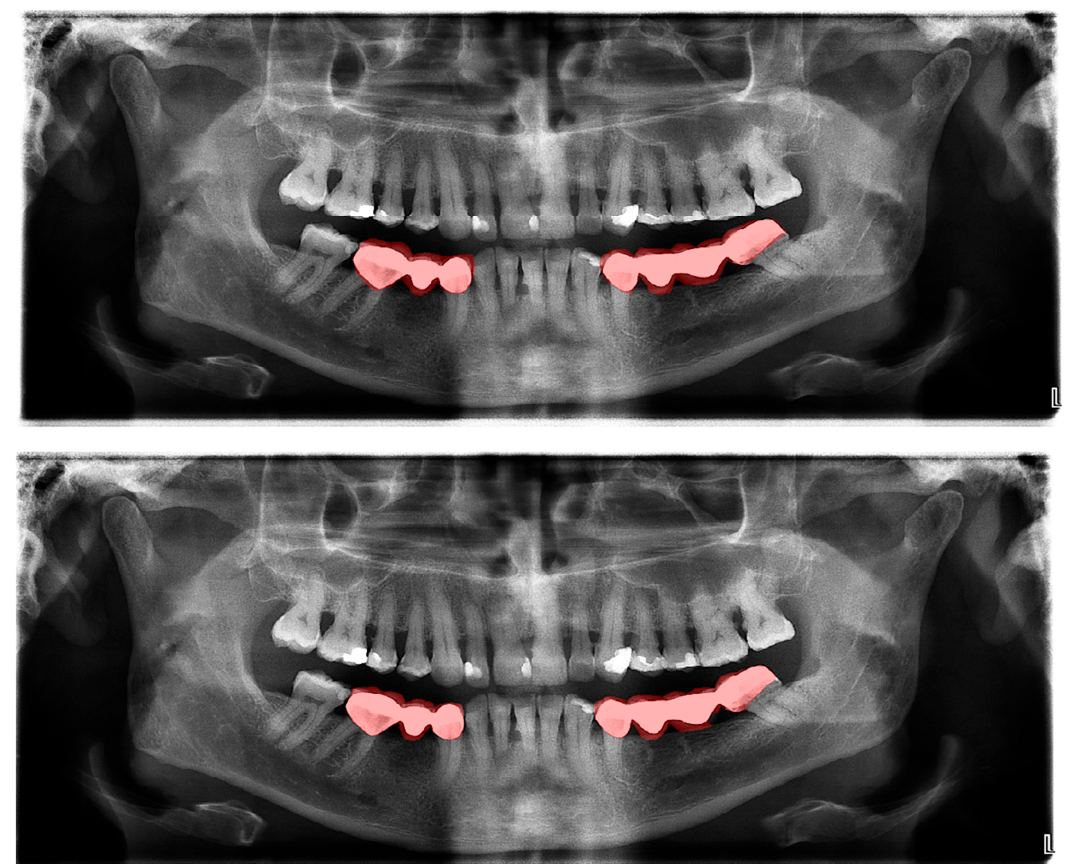
Figure 3. Automatic segmentation of the carious lesions at the upper-left second molar and lower- right first molar. Manual segmentation ( left ) as well as automatic segmentation ( right ) can be seen above.